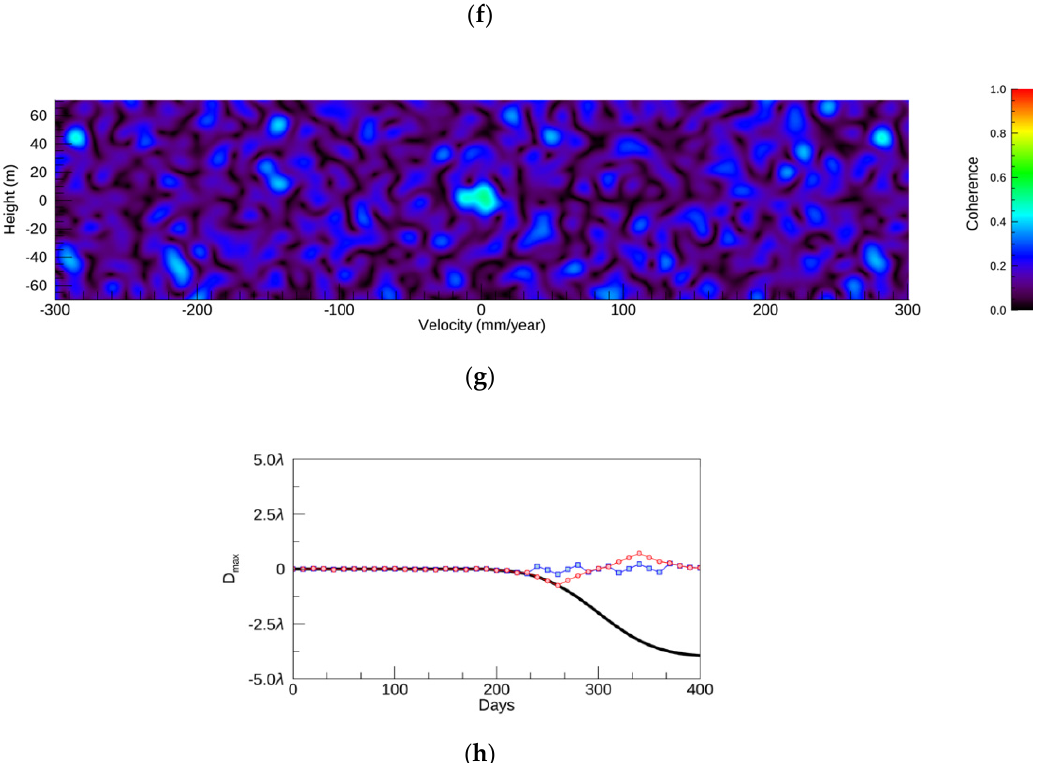
Figure 8. ( a ) The SDM with a CDF variance of 1.5 λ and a velocity range from − 150 to 150 mm / year. ( b ) The original and resulting displacements of ( a ). ( c ) The SDM with a CDF variance of 1.5 λ and a velocity range from − 250 to 250 mm / year. ( d ) The resulting displacements of ( c ). ( e ) The SDM with a CDF variance of 2.5 λ and a velocity range from − 250 to 250 mm / year. ( f ) The resulting displacements of ( e ). ( g ) The SDM with a CDF variance of 4 λ and a velocity range from − 300 to 300 mm / year. ( h ) The resulting displacements of ( g ). In the time plots, the red, blue, and black lines show NN-PSI, ConvPSI, and modeled displacements, respectively.